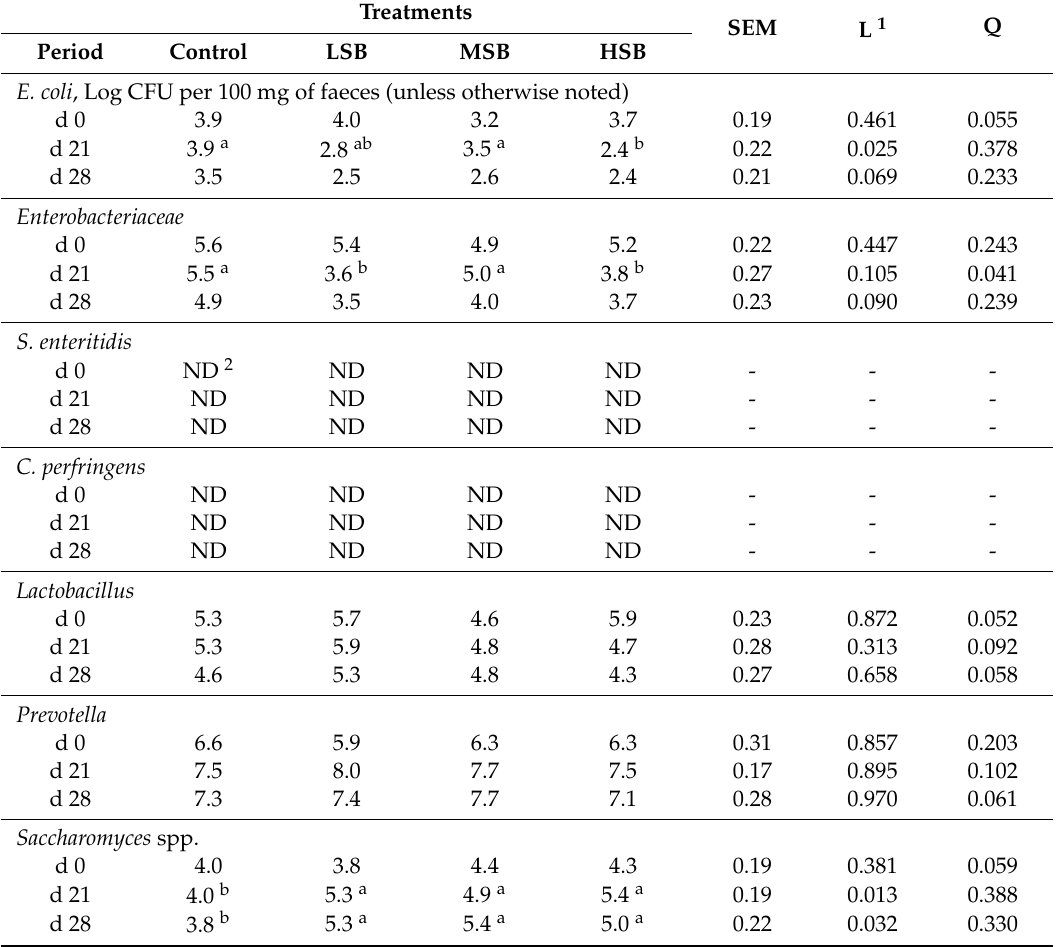
Table 4. Changes in fecal microbes of calves receiving SB during the TN period (d 1 to 21) and HS period (d 22 to